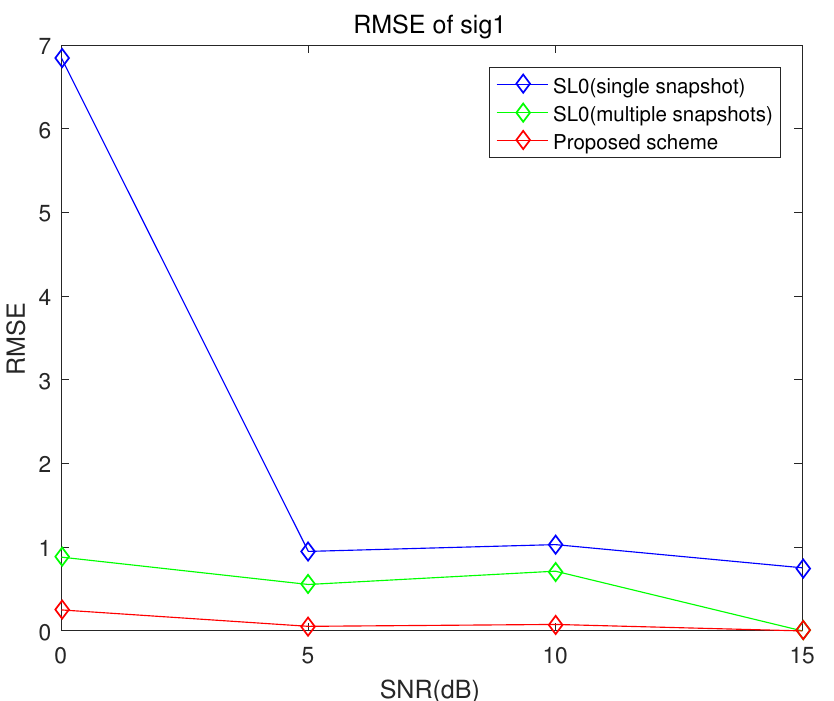
Figure 5. RMSE of the proposed scheme, the conventional smoothed l 0 norm method and multiple snapshots smoothed l 0 norm method when the number of sensors is 10, the number of samples is 100 and the incident angles are 5 ◦ and 20 ◦ (sig1).